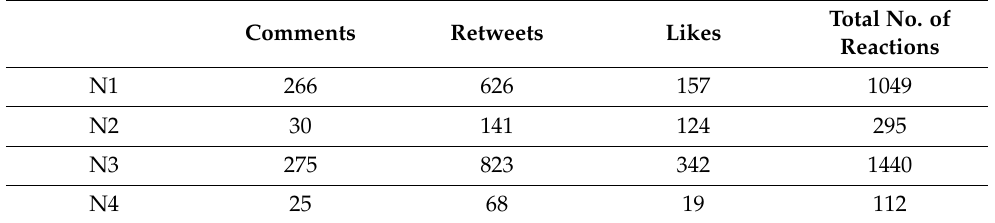
Table 3. Social audience engagement to the hoaxes spread by Mediterráneo Digital .